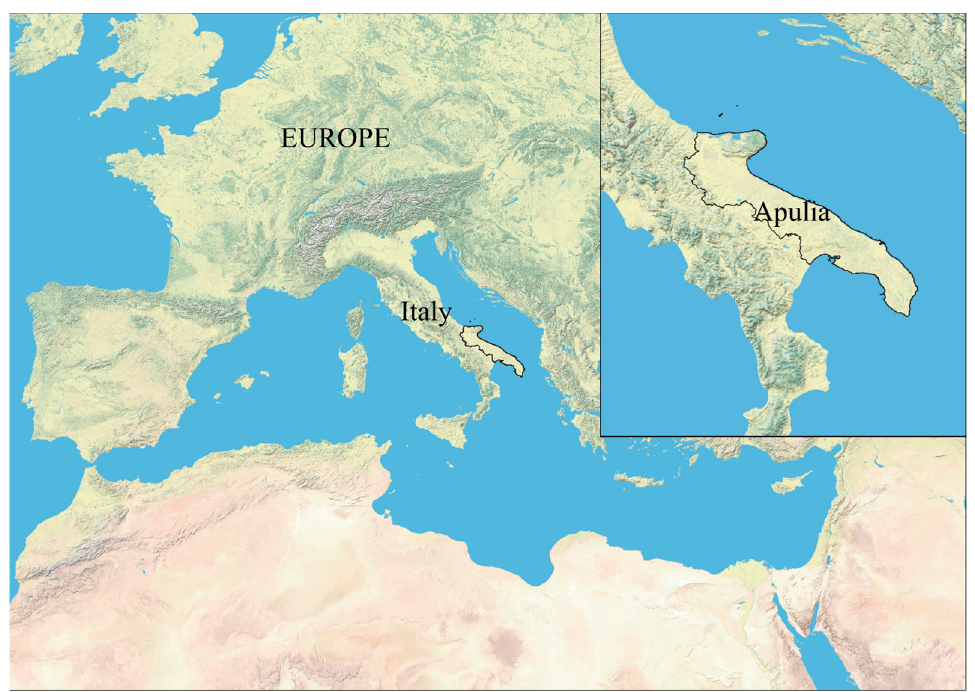
Figure 2. Geographical location on Apulia region (southeastern Italy).